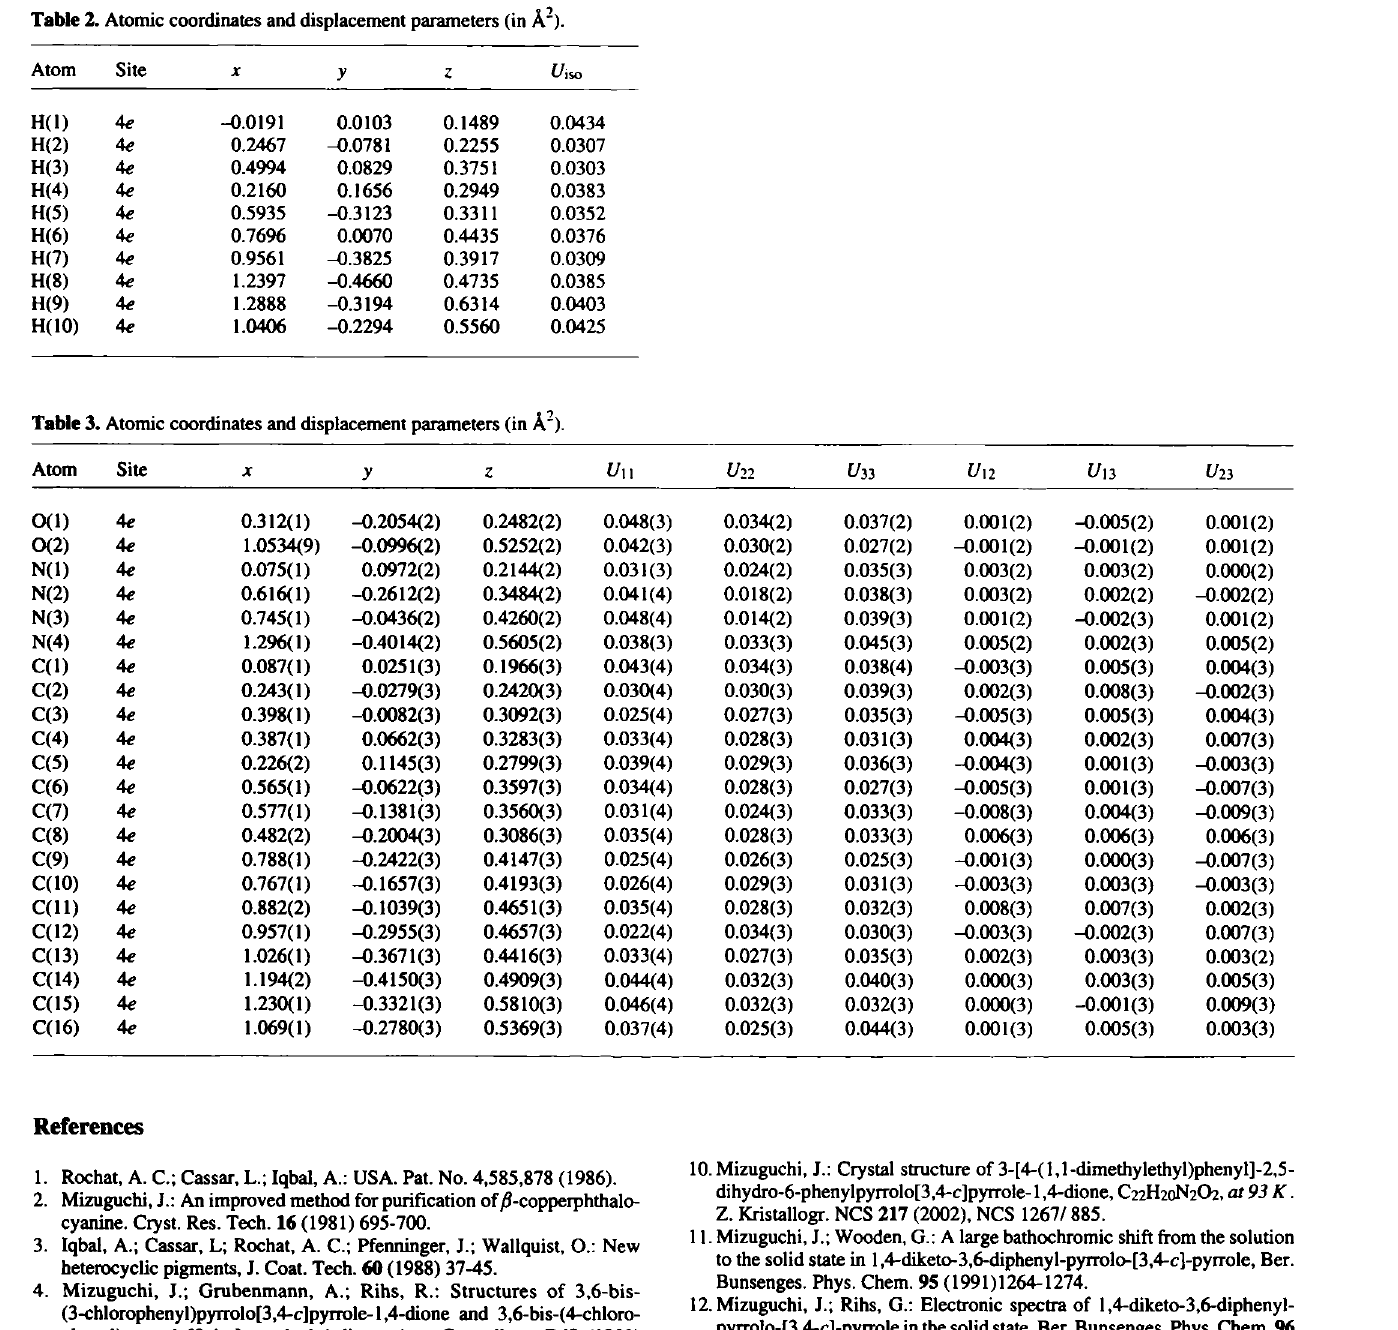
Table 2. Atomic coordinates and displacement parameters (in Â").